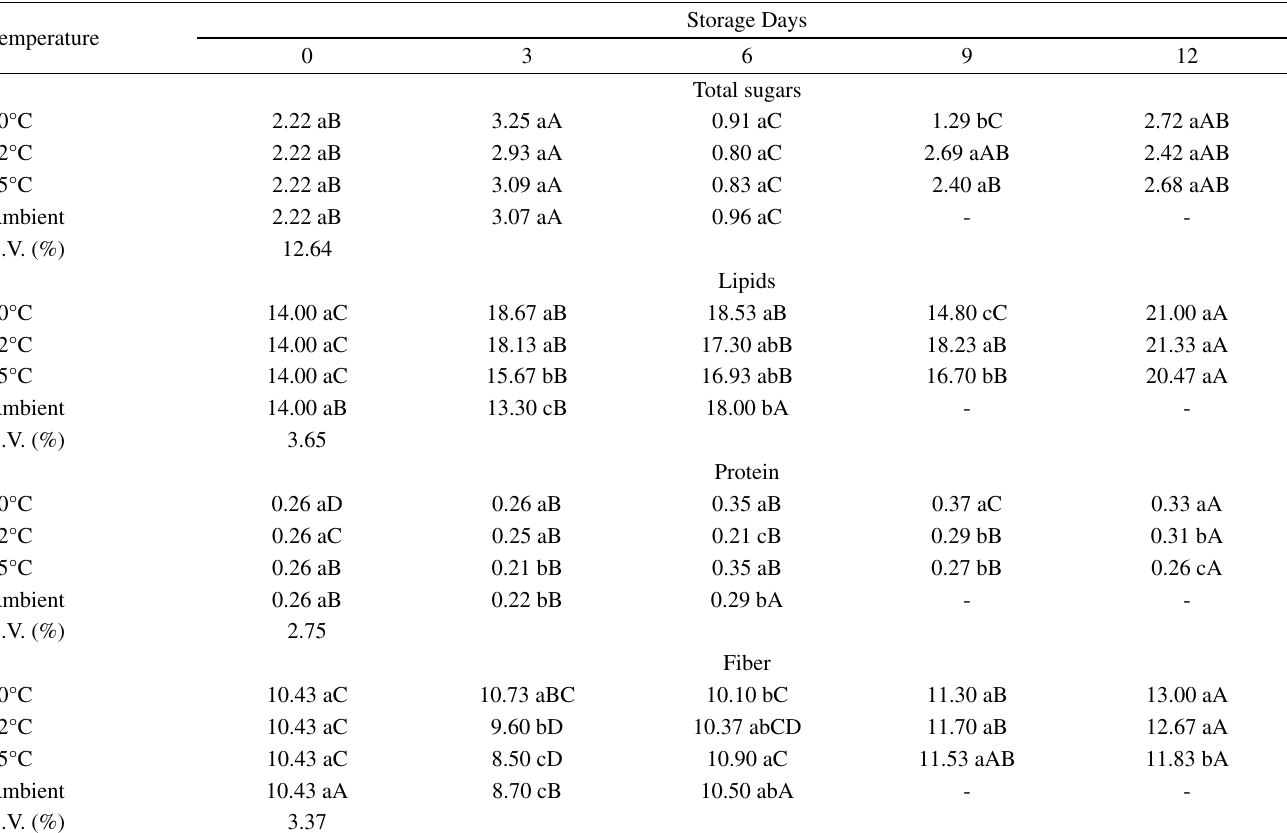
Table 4 - Amounts of total sugars, lipids, protein and fiber (%) in buriti fruits under refrigerated storage (80±5% relative humidity) and